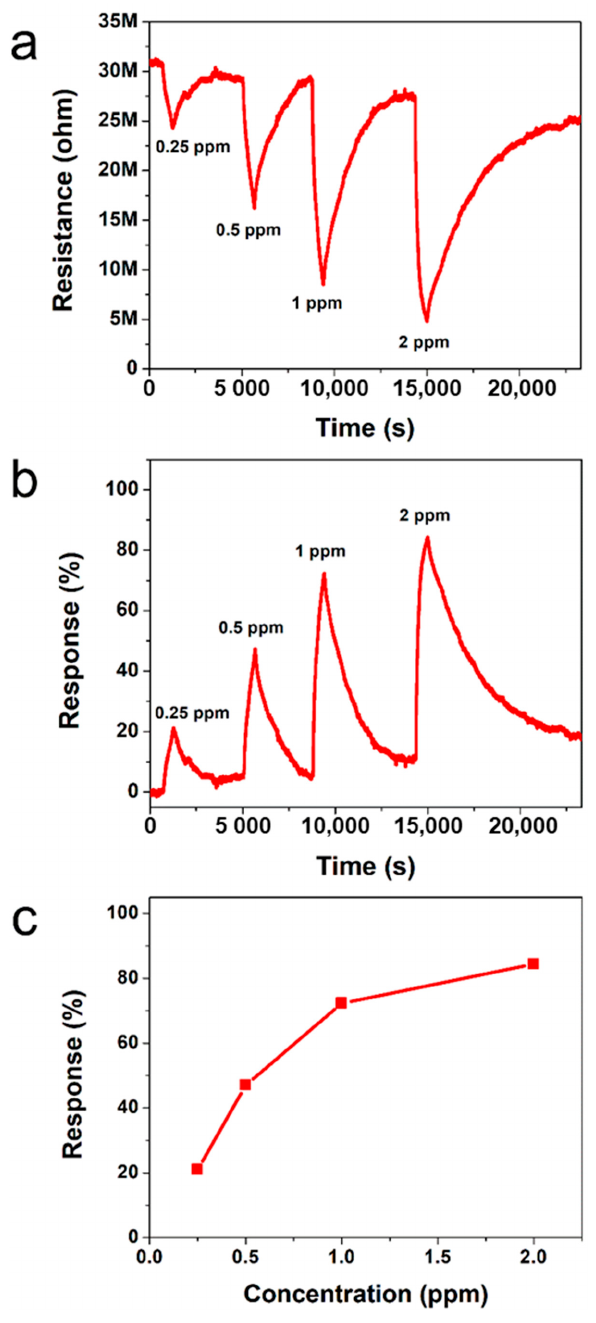
Figure 5. Transient ( a ) resistance and ( b ) response of sensors based on I 2 -doped PTh films to different NO 2 concentrations at RT. ( c ) Responses as a function of NO 2